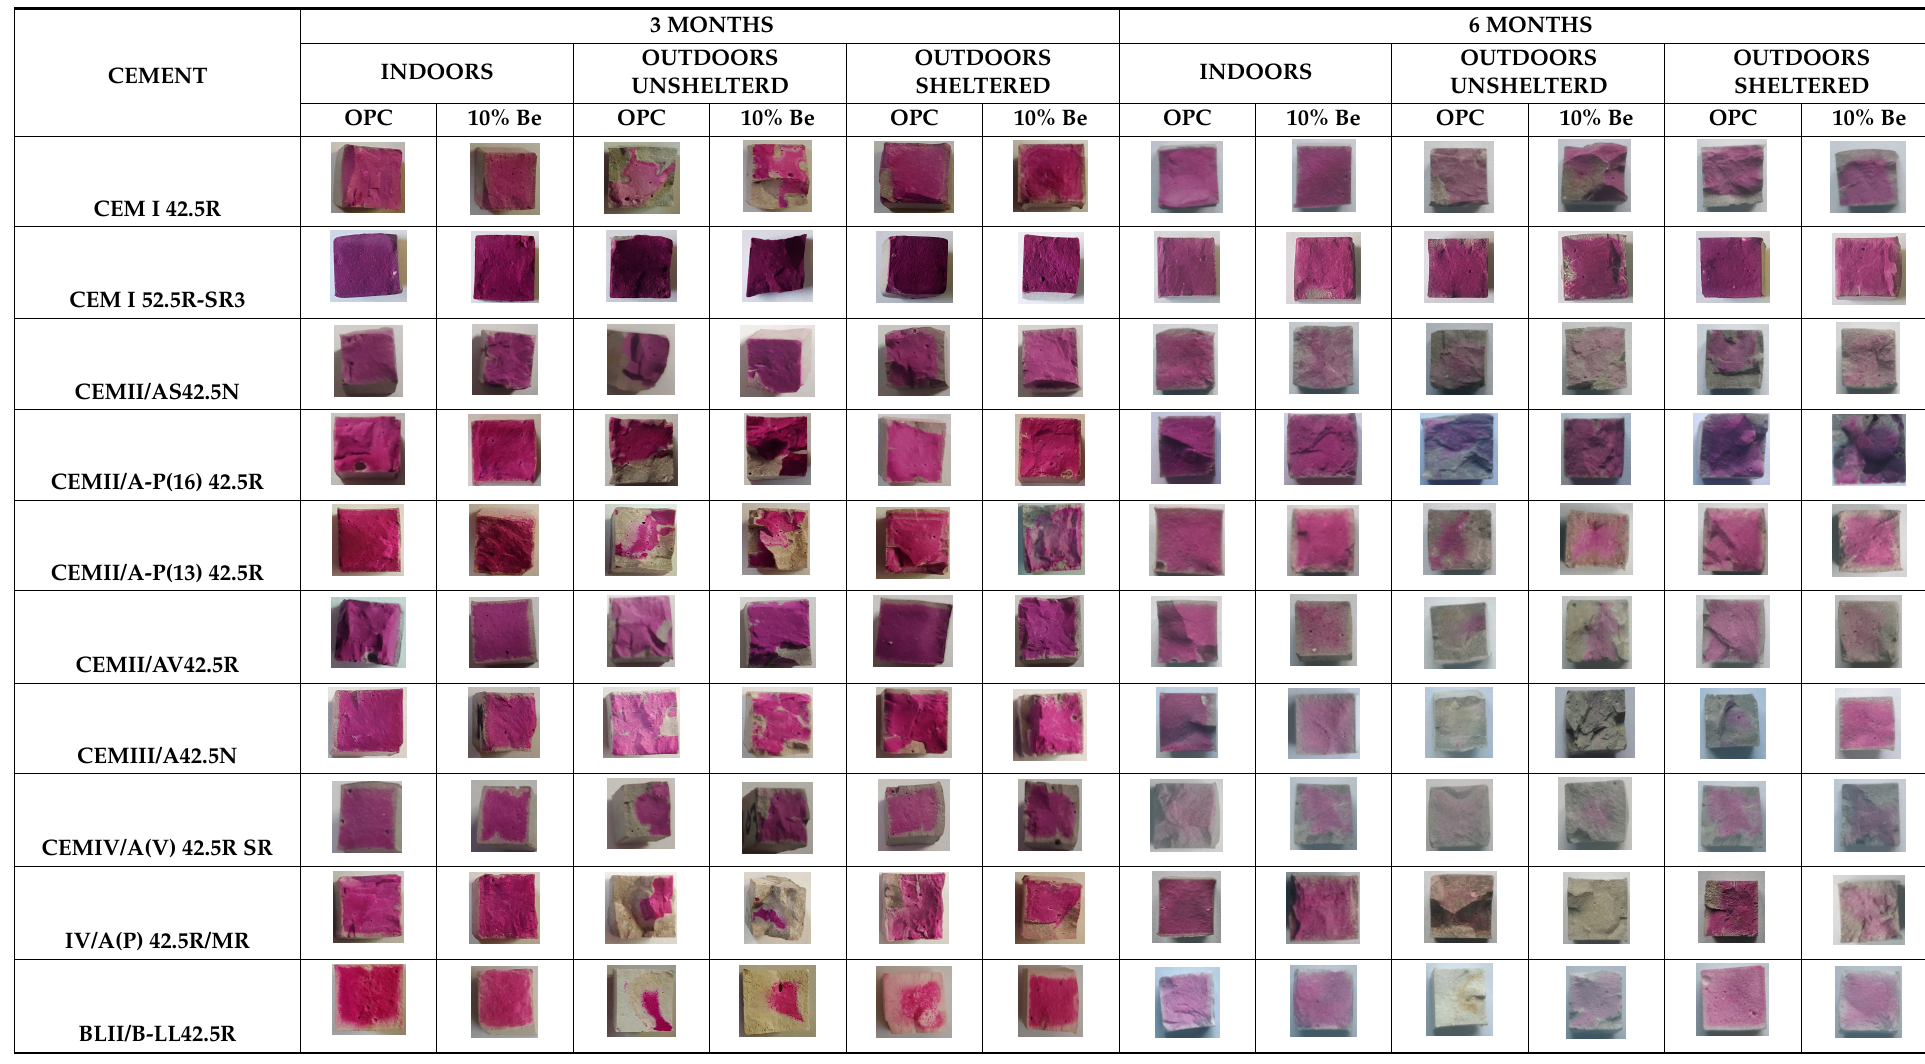
Table 5. Phenolphthalein staining in the cements studied to determine carbonation